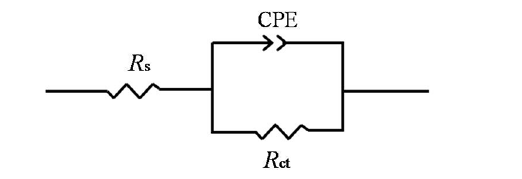
Figure 9. Equivalent circuit for fitting experimental Nyquist impedance plots